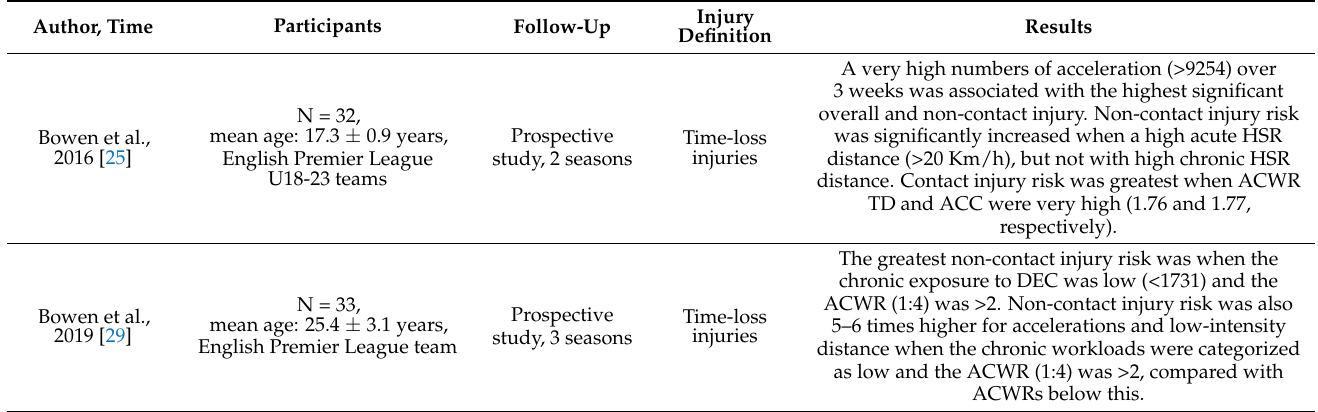
Table 3. Research literature on the relationship between GPS indicators and injury risk in soccer